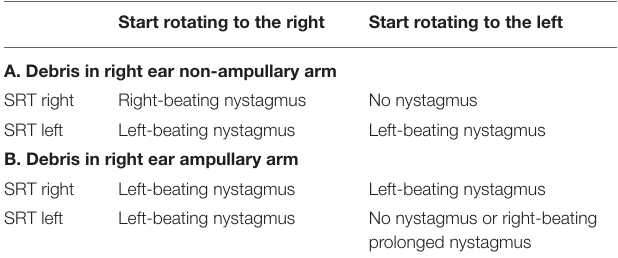
TABLE 2 | Simulation studies of horizontal canalithiasis right ear: (A) Nystagmus patterns of SRT in non-ampullary canalithiasis on starting to the right and left (B) Nystagmus patterns of SRT in ampullary canalithiasis on starting to the right and left.